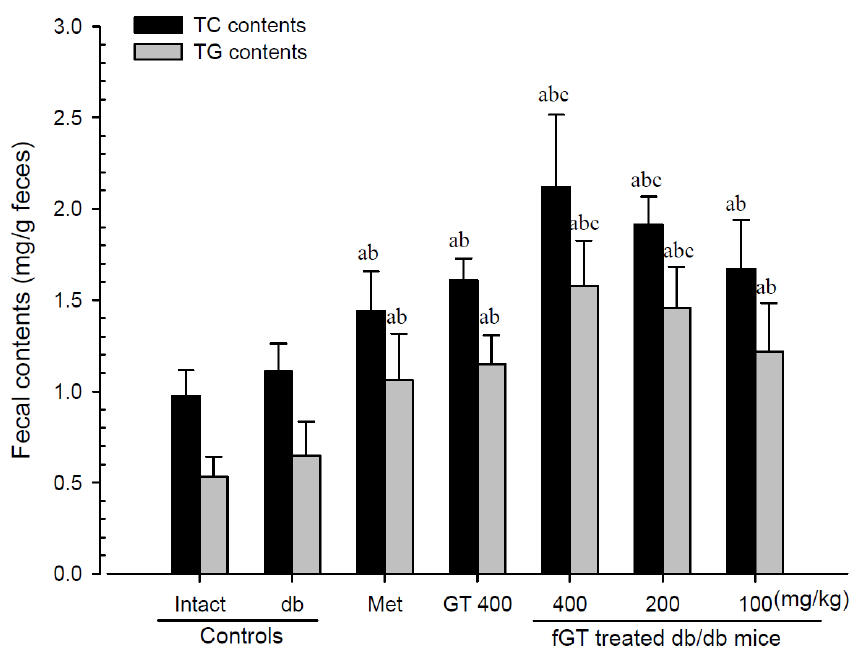
Figure 7. Fecal TC and TG content changes in intact normoglycemic and db/db mice. Values are expressed mean ± S.D. of eight mice. GT, Green tea aqueous lyophilized extracts; fGT, Aquilariae Lignum-fermented green tea aqueous lyophilized extracts; Met, metformin 250 mg/kg treated db/db mice; TC, total cholesterol; TG, triglyceride. a p < 0.01 as compared with intact control by LSD test; b p < 0.01 as compared with